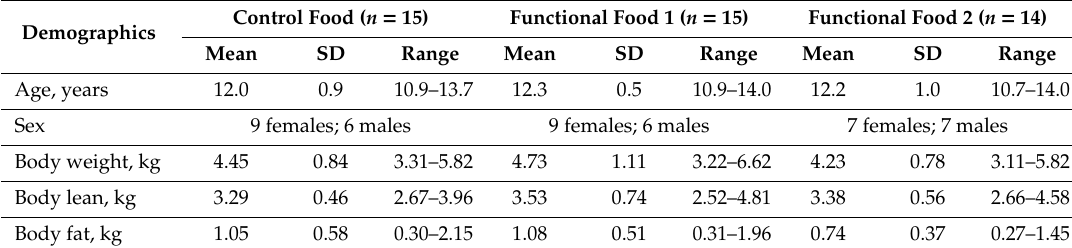
Table 1. Demographic data at baseline for senior-adult cats fed control food, or functional foods 1 and